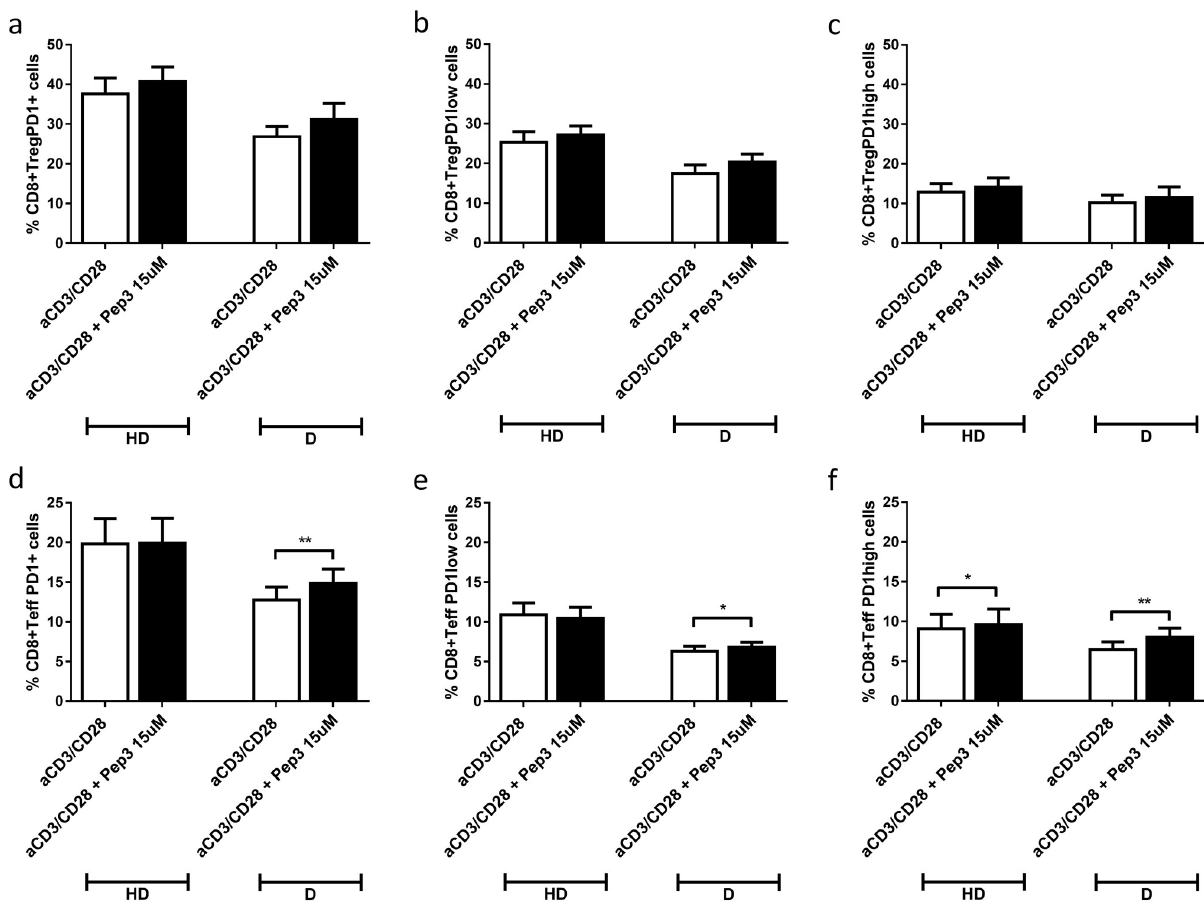
Fig 5. Frequency of CD8+PD1+ cell populations in PBMC of HD and type 1 diabetes upon treatment with peptide 3 and subsequent stimulation with anti-CD3/CD28 beads for 4 days. Flow-cytometry analysis of HD and type 1 diabetes PBMC following 15 μ M of Pep3 treatment and subsequent stimulation for four days with anti-CD3/CD28 beads. Graphs show the percentage of CD8+ Treg PD1+ cells ( a ), CD8+ Treg PD1low cells ( b ), CD8+ Treg PD1high cells ( c ), CD8+ Teff PD1+ cells ( d ), CD8+ Teff PD1low cells ( e ), CD8+ Teff PD1high cells ( f ). Percentages of PD1+, PD1low and PD1high cells were evaluated in comparison to the corresponding parental subset under evaluation. Values correspond to mean frequency ± SEM of 14 healthy controls (HD) and 16 long-term type 1 diabetes patients (D). � p < 0.05, �� p < 0.01.